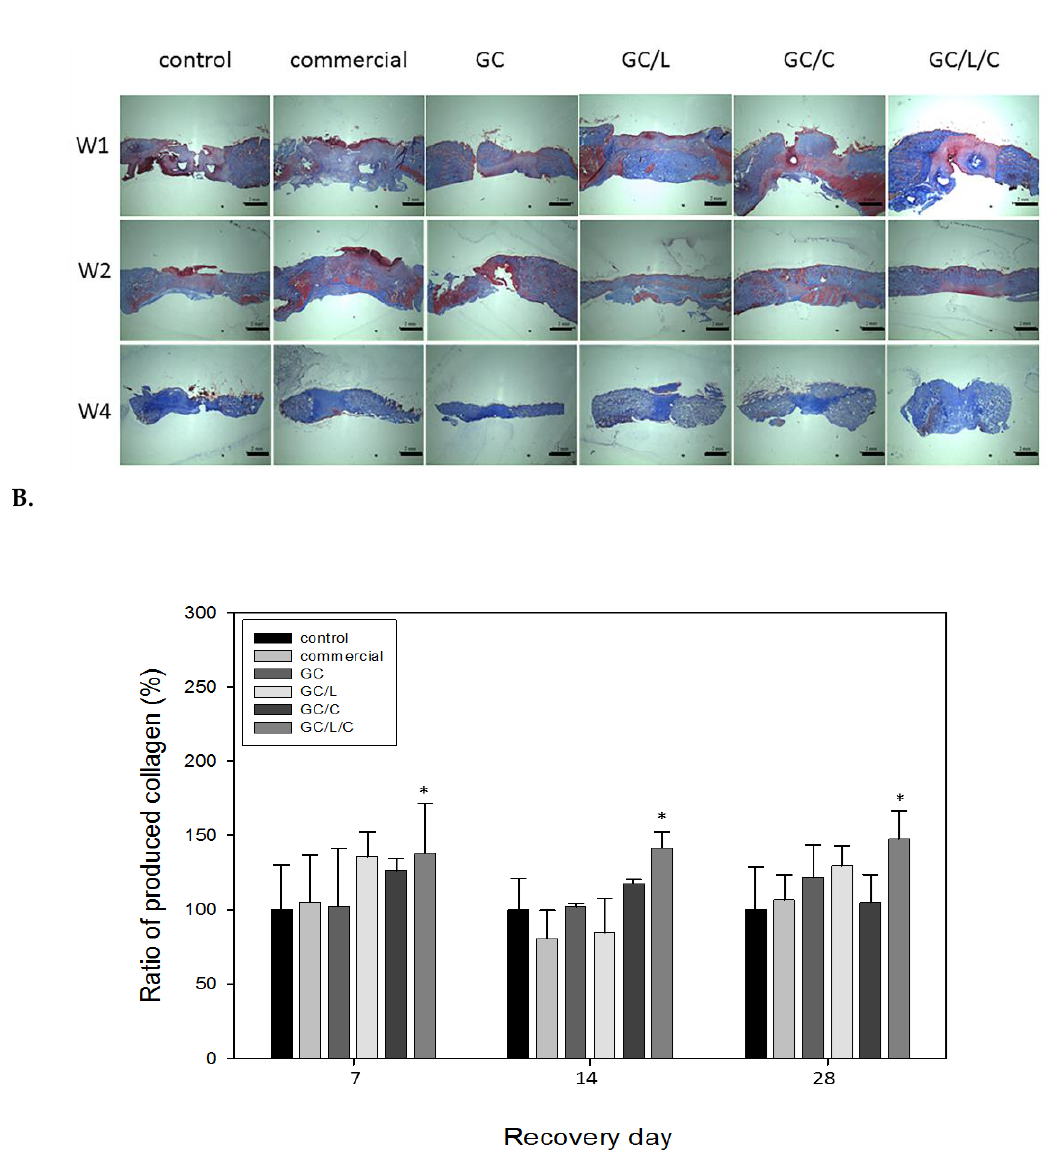
Figure 8. ( A ) Masson’s trichrome staining images of wound area treated with a GC, GC / L, GC / C, and GC / L / C sca ff olds, commercial (Comfeel ® ) or gauze (control) at seventh, 14th and 28th day. ( B ) The collagen content of the seventh, 14th and 28th day-specimens of wound areas treated with di ff erent sca ff olds. * Compared with the control group, p <0.05.